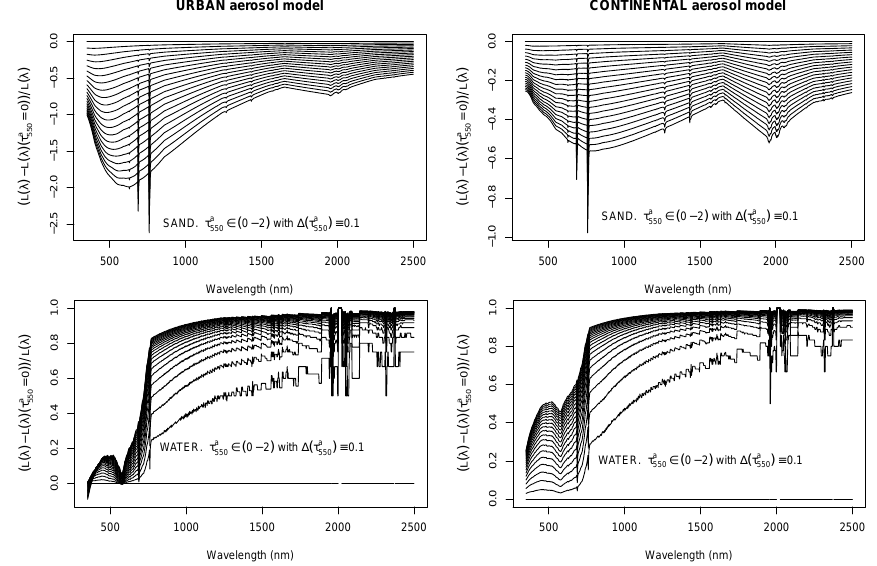
Fig. 3. δL = (L(λ) − L 0 (λ))/L(λ) with τ a 550 ∈ 0 . 0 , 2 . 0 with ∆ τ a = 0 . 1 using the urban (left column) and continental (right column) aerosol model for sand (first row) and water (second row).